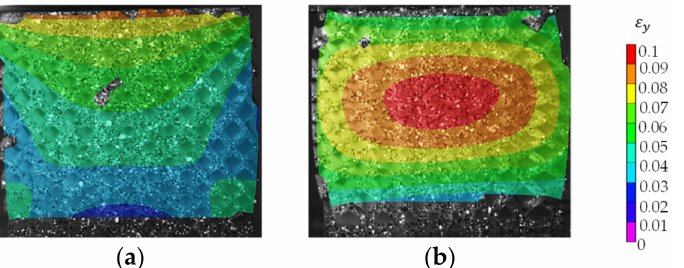
Figure 12. Digital Image Correlation (DIC) results depicting the two common engineering strain distribution patterns in the vertical direction at 10% compressive strain ( a ) unidirectional and ( b ) con- centric strain distributions